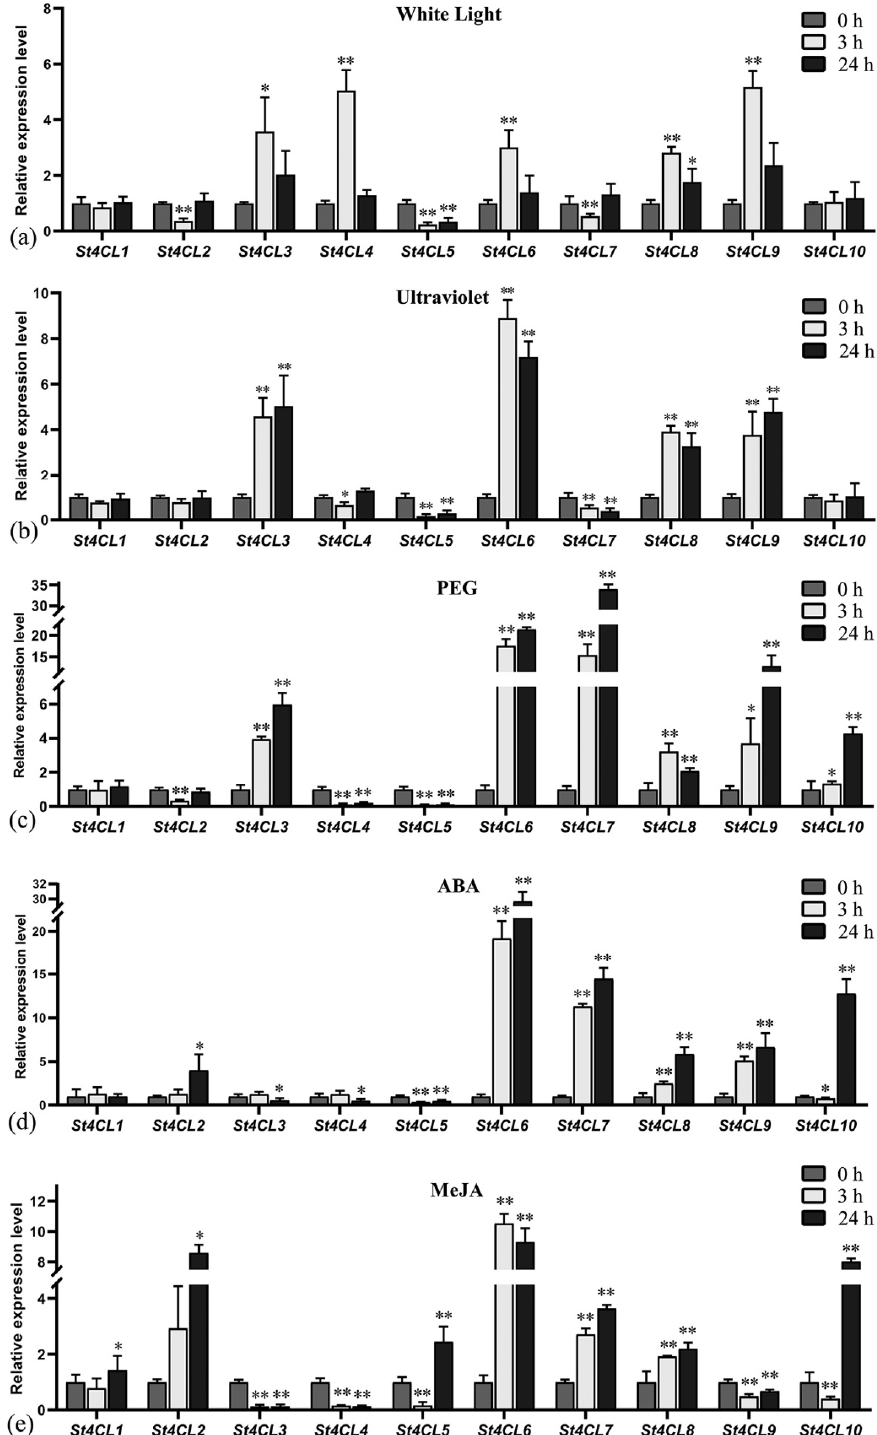
Figure 8. St4CL genes expression changed in response to different treatments. ( a ) Relative expression levels of St4CLs under constant white light treatment. ( b ) Relative expression levels of St4CLs under ultraviolet radiation. ( c ) Relative expression levels of St4CLs upon PEG simulated drought stress. ( d ) Relative expression levels of St4CLs under ABA treatment. ( e ) Relative expression levels of St4CLs under MeJA treatment. The data are shown as mean values ± SD (n = 3). (* t -test p -value < 0.05, ** t -test p -value <